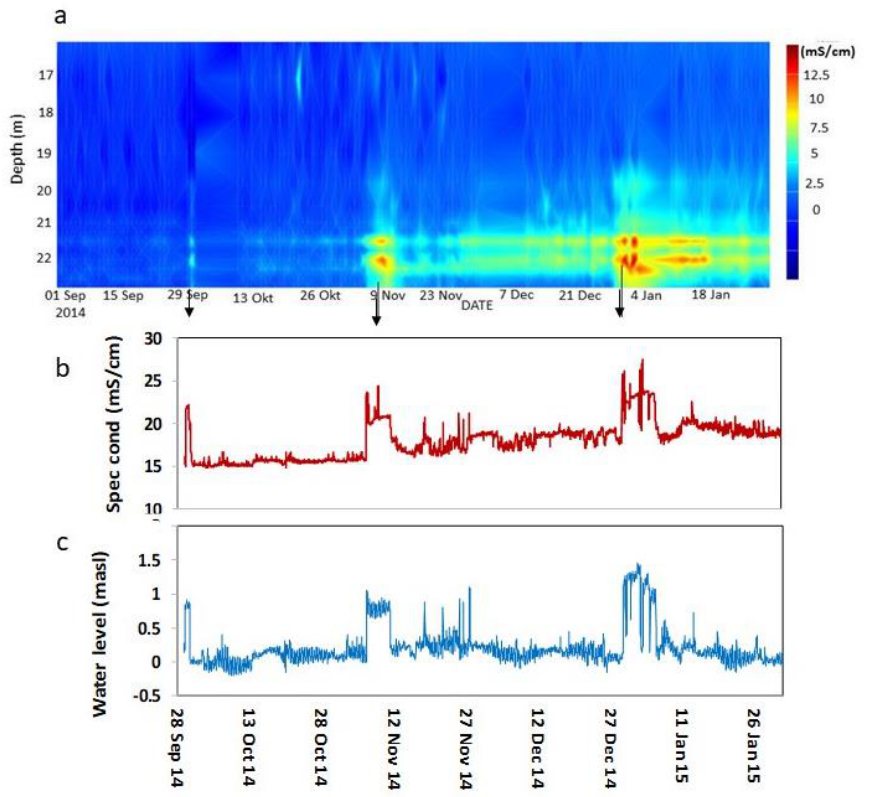
Figure 9. SMD ( a ) and conductivity temperature depth (CTD) ( b , c ) measurements in well 71-2 between September 2014 and January 2015. ( a ) Shows the difference in electric conductivity (mS/cm) compared to the beginning (date 1 September 2014). Times of shutdown of the pump in well p211 are indicated by arrows. CTD located at depth of 20.5 m.